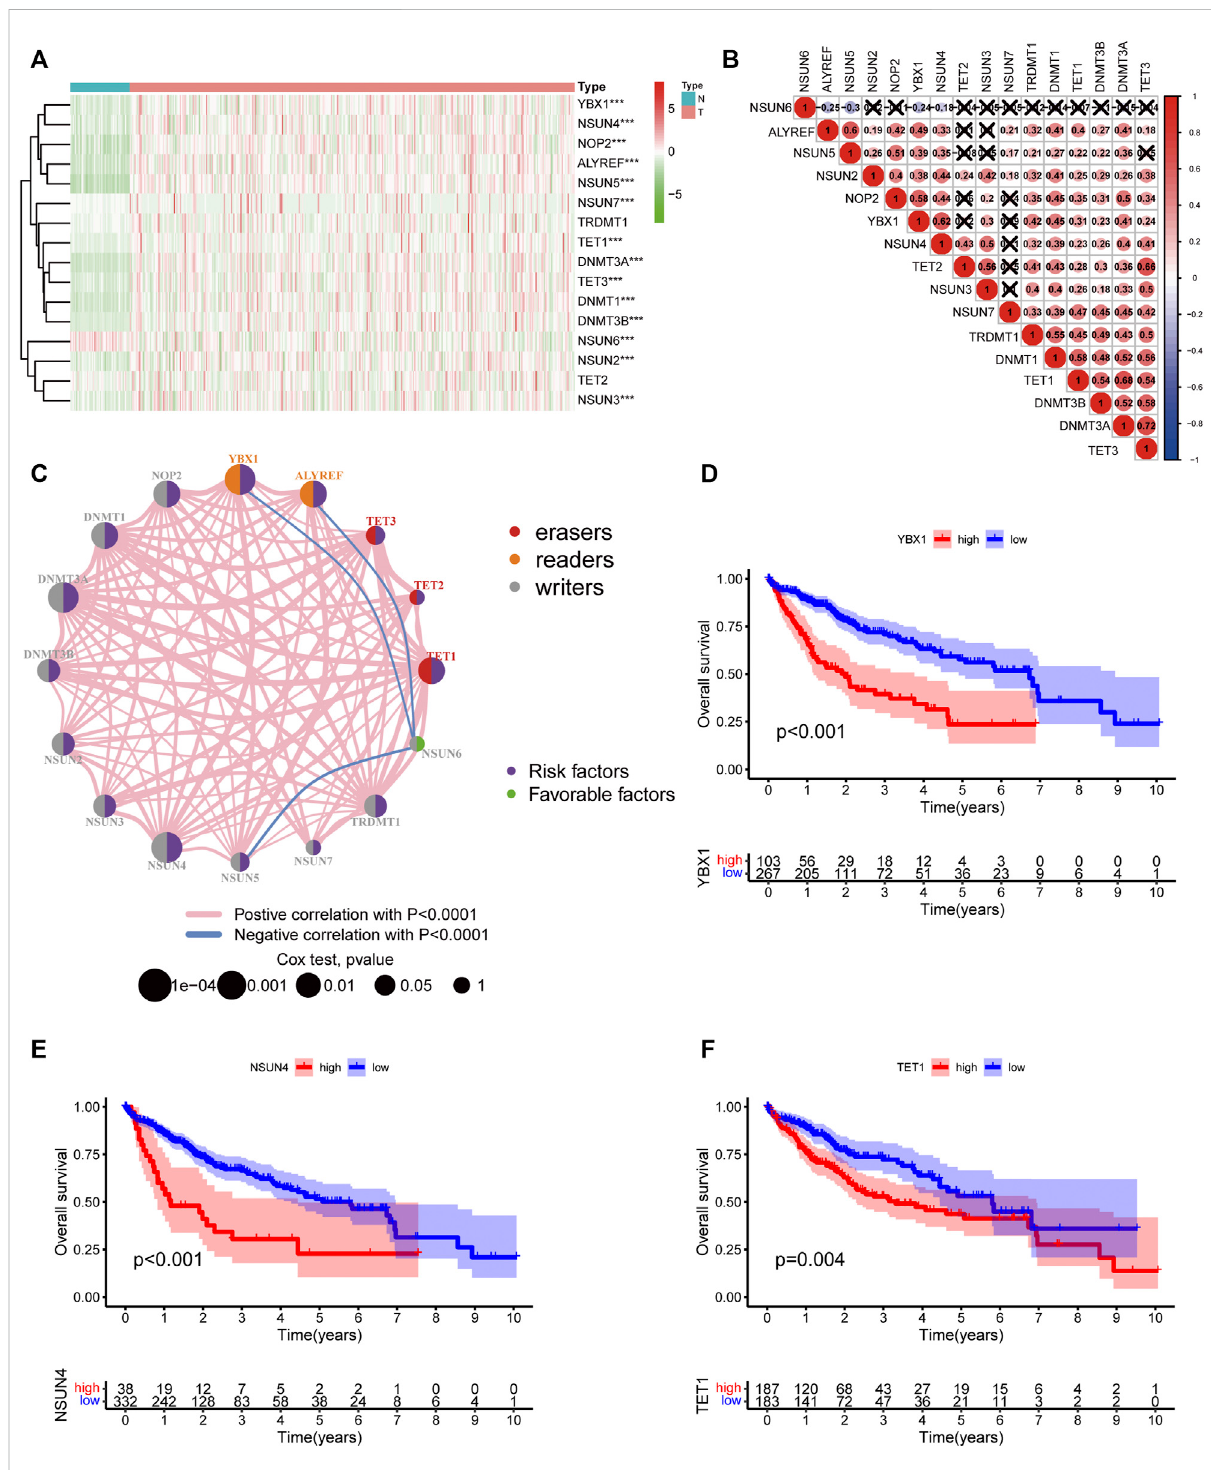
FIGURE 2 The landscape of expression and prognosisof m5C regulators in HCC patients. (A) Heatmap displaying different expressions of m5C regulators in HCC. (B) Spearman correlation analysis of 16 m5C regulators. (C) The interaction between m5C regulators in HCC. The size of the circle represented thein fl uenceofeachregulatoronprognosis,and therange ofvalues calculated bylog-rank testwas p < 0.0001, p < 0.001, p < 0.01, p < 0.05, and p < 1. Purple in the right part of the circle indicates risk survival factors and green in the right part of the circle indicates favorable survival factors. The types of m5C regulators are labeled as different colors in the left part of the circle. The thickness of lines shows correlation strength. Positive correlation is shown in pink and negative correlation in blue. (D – F) Overall survival analysis based on three m5C regulators ’ expression in